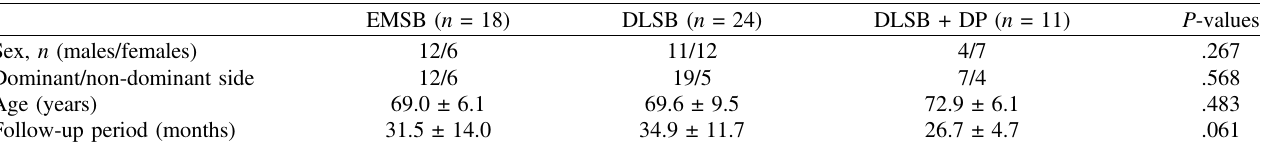
Table 1. Patient